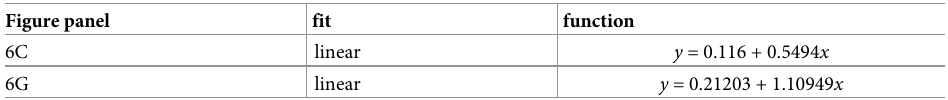
Table 1. Calculated functions for the regressions. Figure panel fit